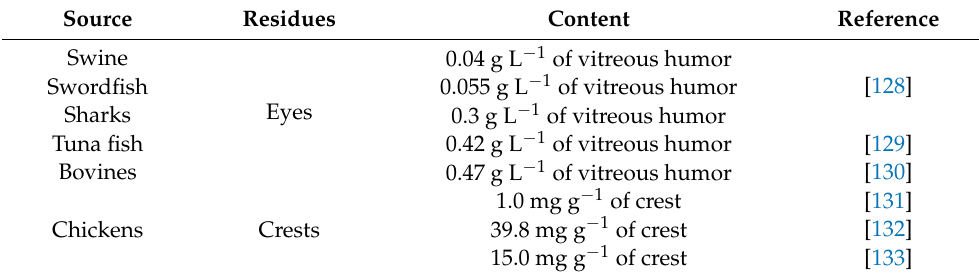
Table 3. Hyaluronic acid content from different